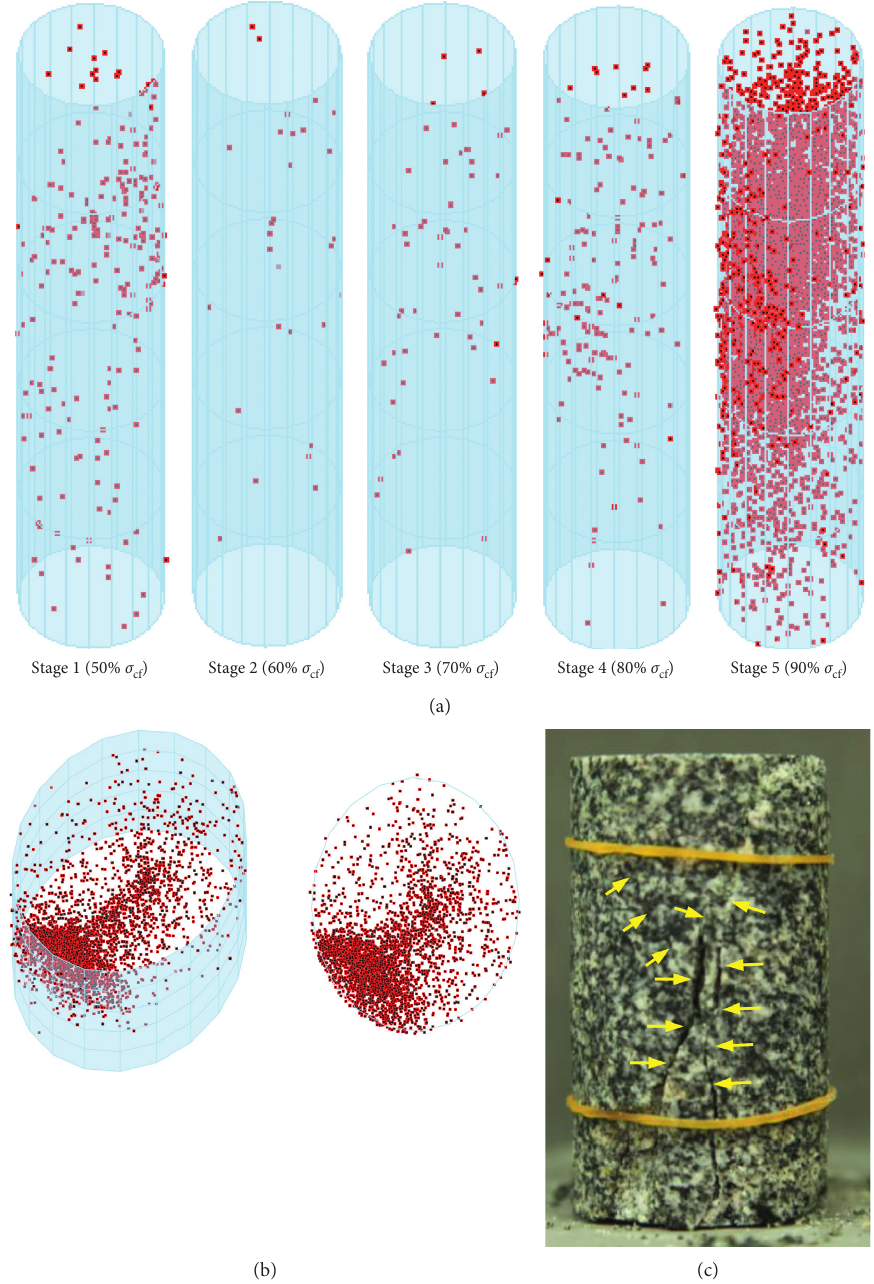
Figure 8: AE spatial distribution and failure pattern of loading-cracked specimen at low confinement (specimen L2, σ spatial distribution at different creep stages. (b) AE events at the last stage with amplitude > 45 dB. (c) Failure